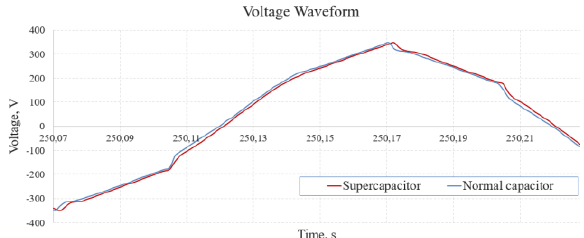
Figure 11. Voltage waveform on the input of frequency converter